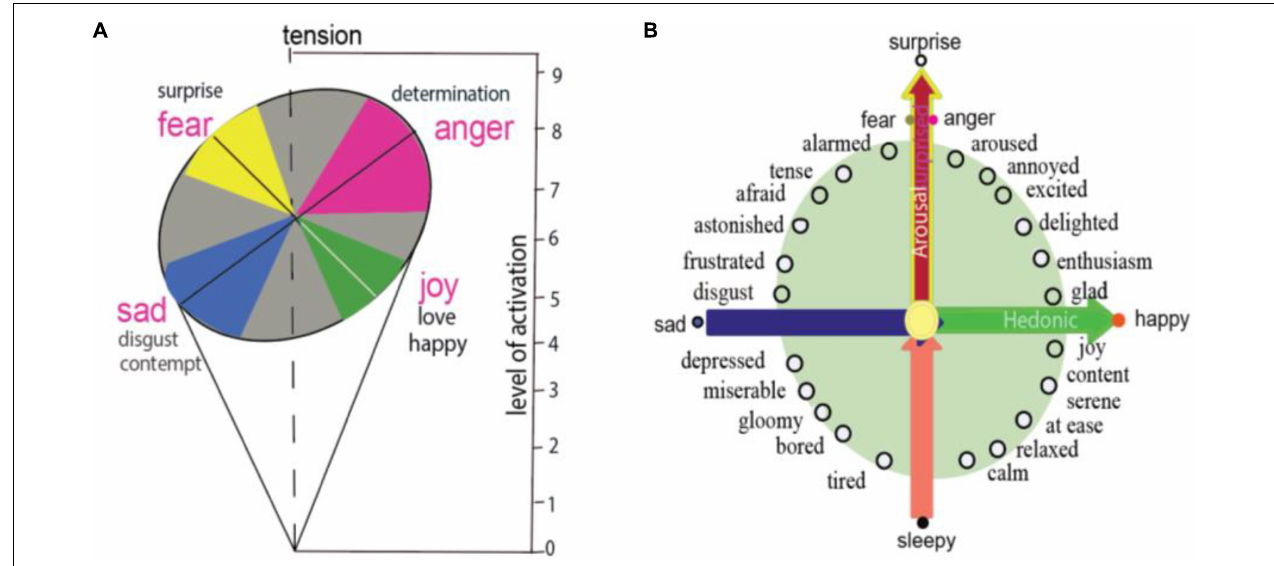
FIGURE 1 | Basic emotion and circumplex. (A) Schlosberg proposed two-dimension of facial expression in a roughly circular surface, whose axes are pleasantness–unpleasantness and attention–rejection. The four basic emotions have different levels of activation, for example, fear and anger can reach higher levels of activation. (B) Circumplex model of emotion proposed that all emotions locate specially on a circle of the circumplex, means that different emotions have different arousal or hedonic parameters . Two core affects of emotions, which are represented on the horizontal dimension and vertical dimension, are induced by two features of a stimulus: the safety value of the stimulus and the hedonic value of the